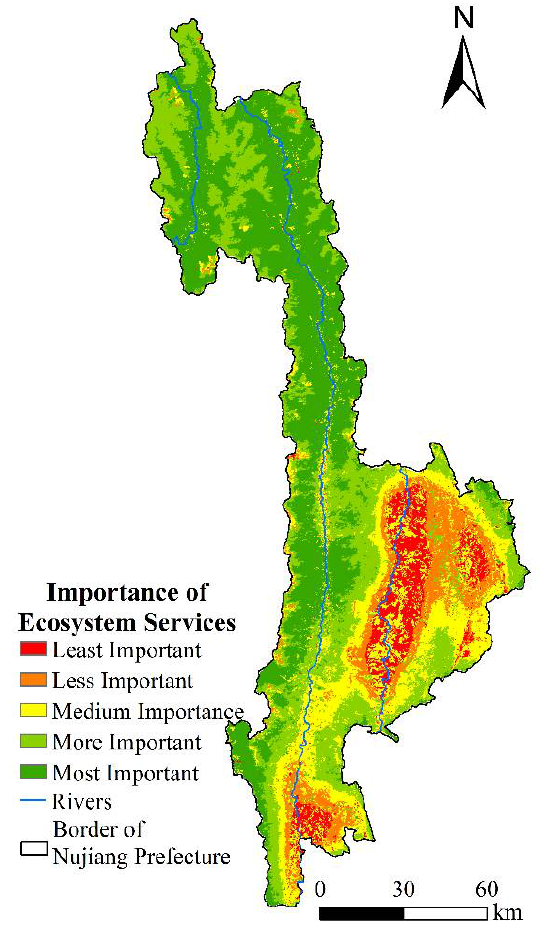
Figure 4. The importance of ecosystem services in Nujiang Prefecture.